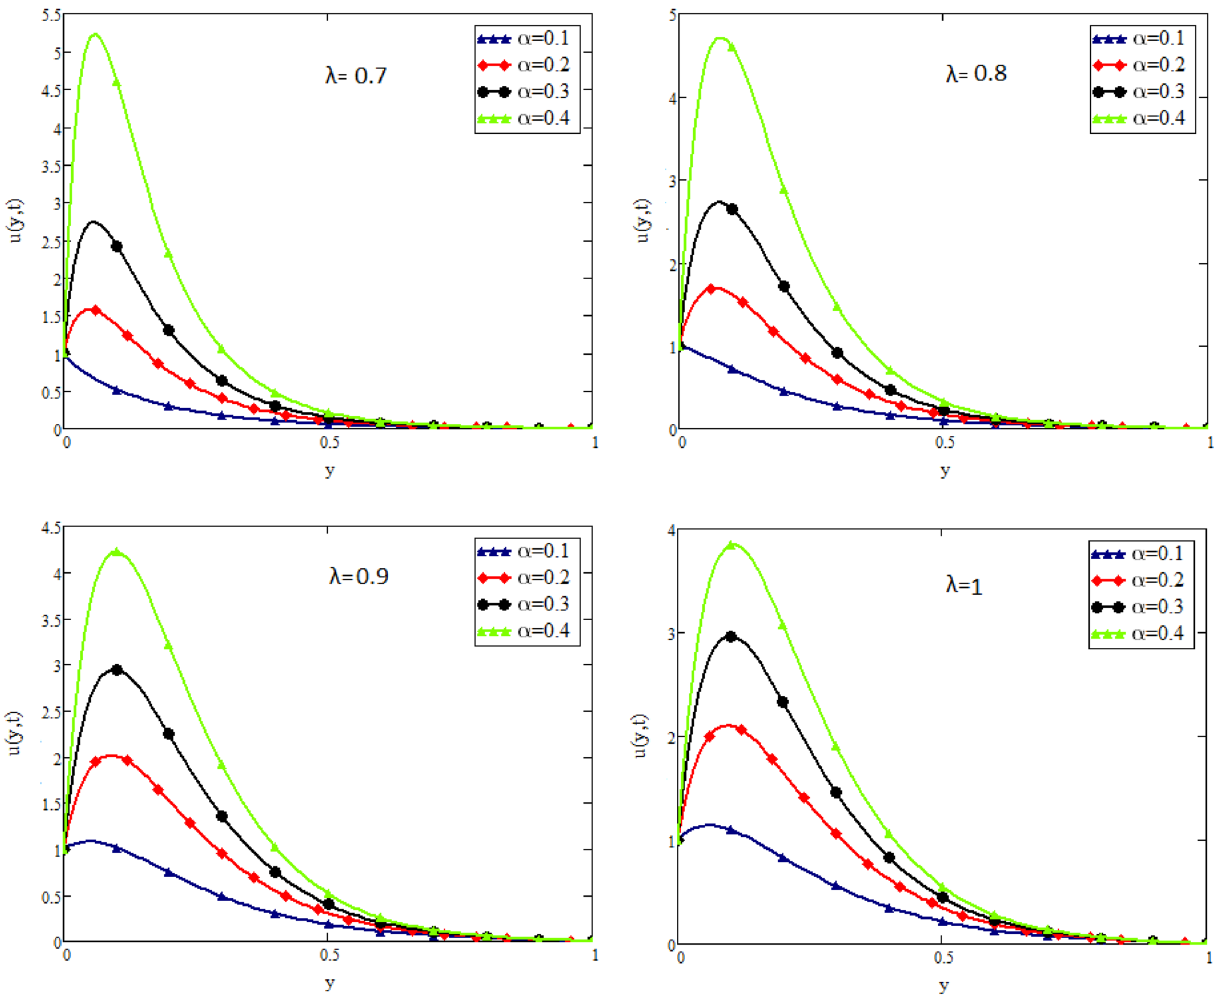
Figure 8. Impact of (cid:31) on velocity distribution when t = 1 , Gr = 1.5 , Gm = 1.5 , Pr = 20 , Sc = 20 , and, β = 2 .